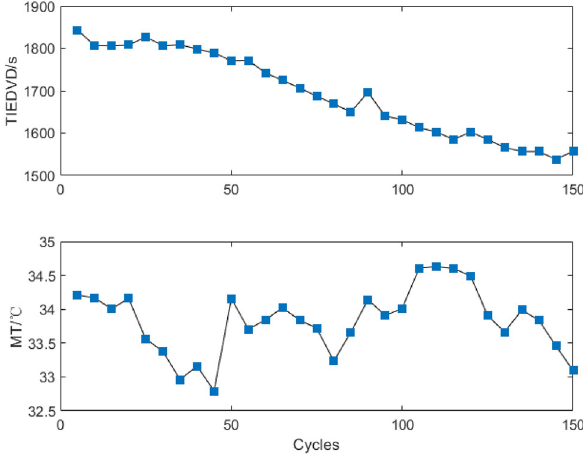
Fig. 5 The B7 TIEDVD and MT with an initial sampling number of 30 the generator and 1 represents that the discrimination result is the real data. The training rounds of the network are 1,200, and the learning rate is 0.002.